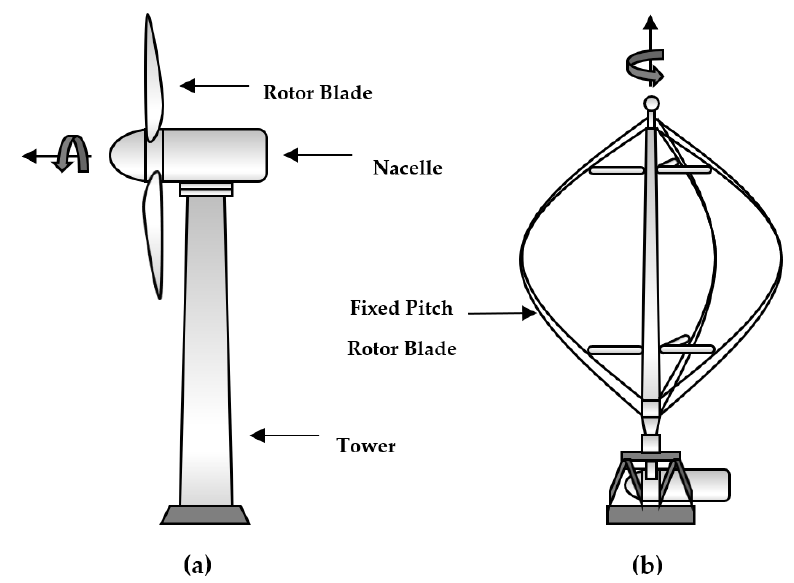
Figure 16. Wind turbine configurations [129]: ( a ) horizontal axis, and ( b ) vertical axis.